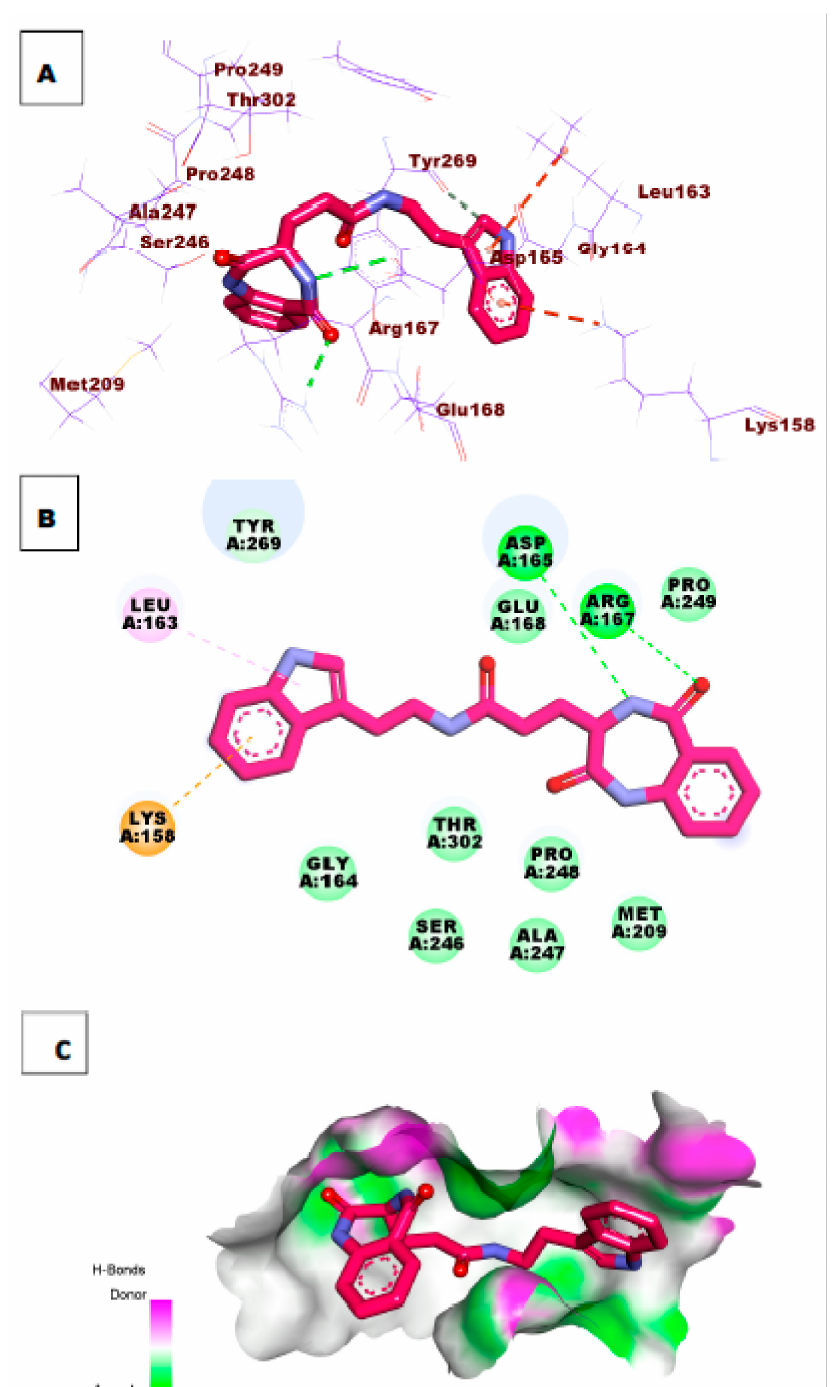
Figure 7. ( A ) 3D of compound 34 docked into the active site of PLpro. ( B ) 2D of compound 34 docked into the active site of PLpro. ( C ) Surface mapping of compound 34 docked into the active site of